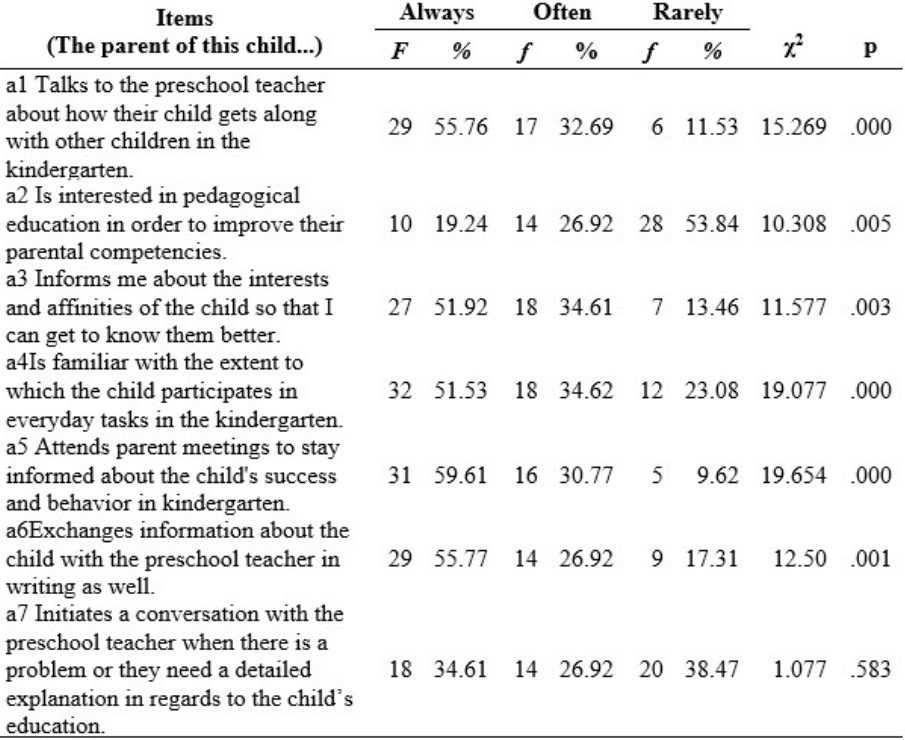
Mutual information-sharing between parents and preschool within the integrated approach